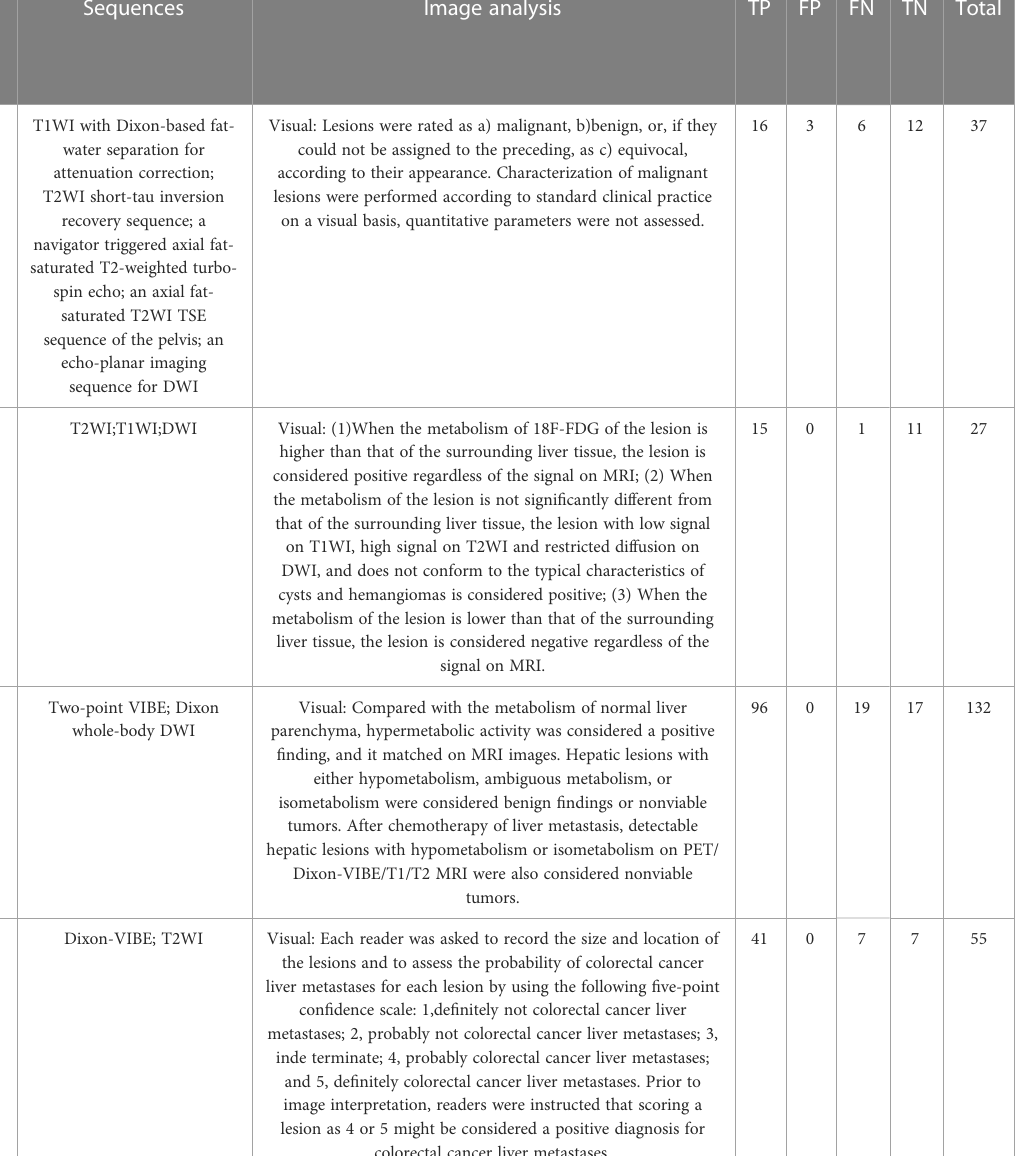
Visual: Lesions were rated as a) malignant, b)benign, or, if they could not be assigned to the preceding, as c) equivocal, according to their appearance. Characterization of malignant lesions were performed according to standard clinical practice recovery sequence; a on a visual basis, quantitative parameters were not assessed. navigator triggered axial fat-